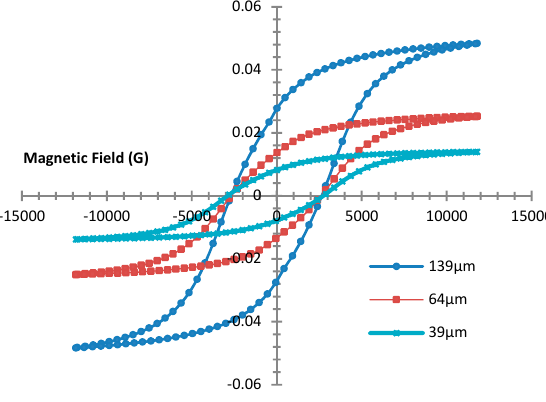
Figure 3. The hysteresis loop of the 6% NdFeB polymer composite.